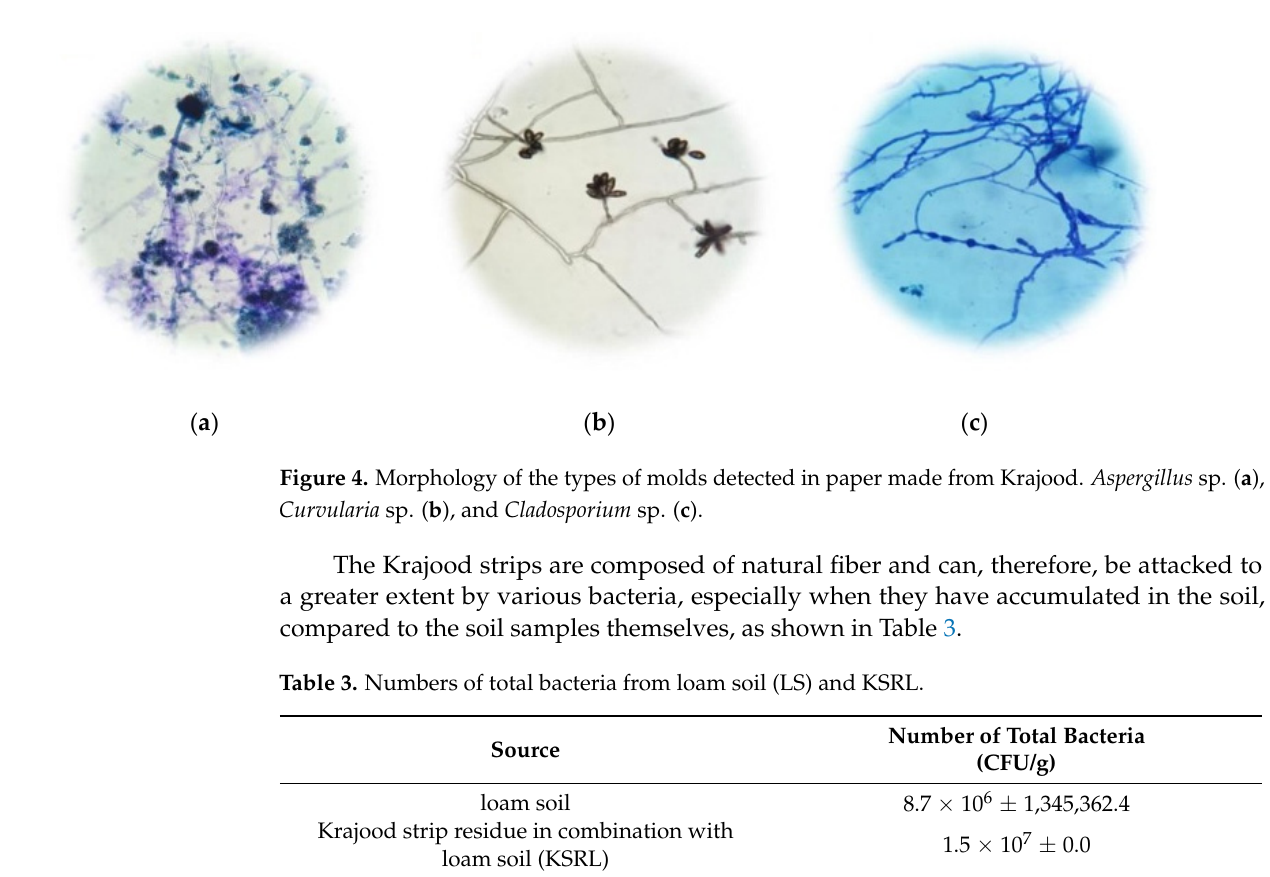
Figure 3. Morphology of Aspergillus sp. detected from Krajood strips.